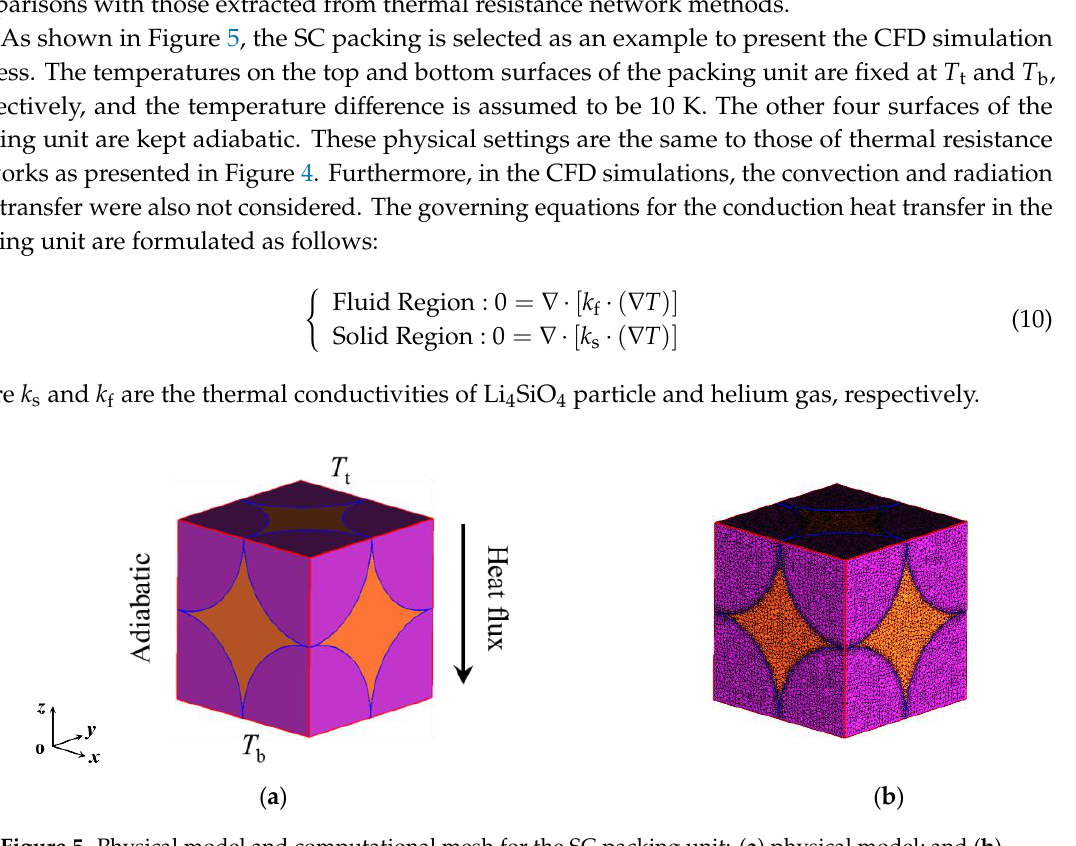
Figure 5. Physical model and computational mesh for the SC packing unit: ( a ) physical model; and ( b ) computational mesh.